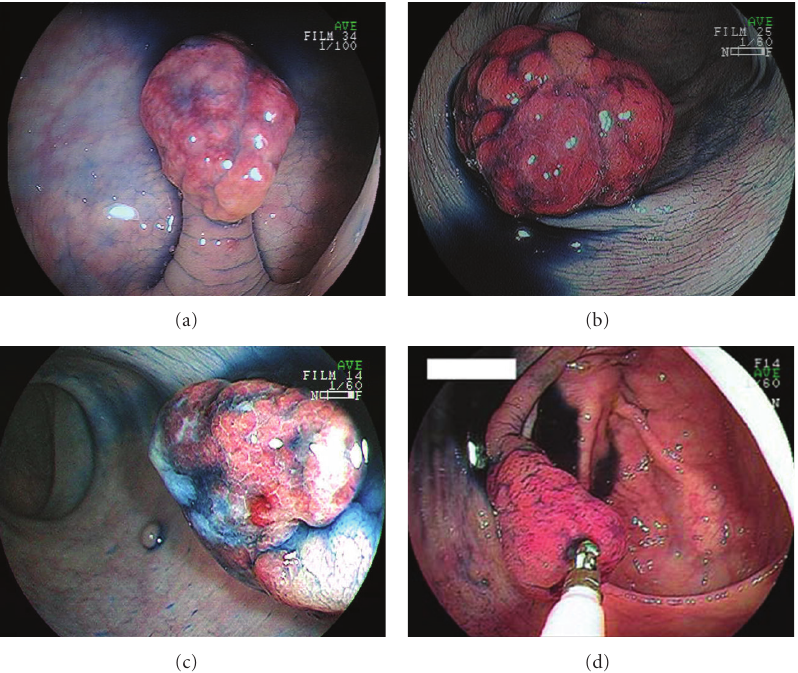
Figure 1: Endoscopic appearances of 4 inflammatory myoglandular polyps. All lesions were red and pedunculated polyps.